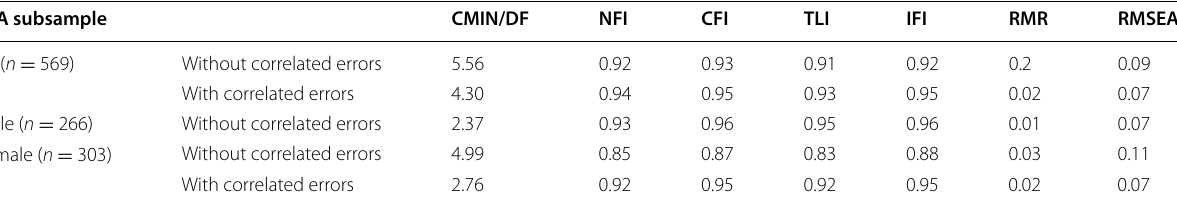
Table 4 Fit indices of the confirmatory factor analysis (CFA) model with and without correlated errors